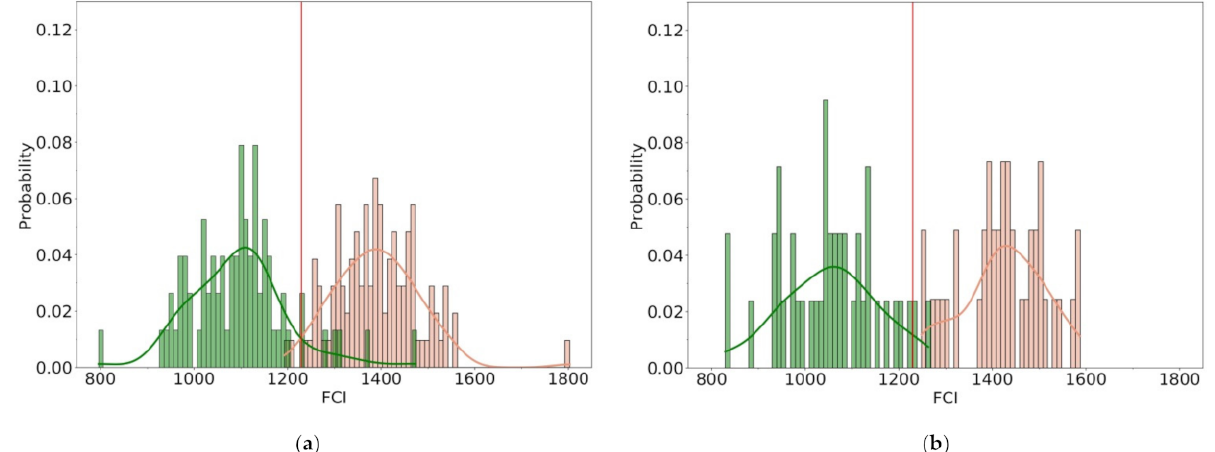
Figure 6. The frequency histograms of FCI values distribution of forest cover (green) and grassland (rose) classes: ( a ) sample points; ( b ) control points.